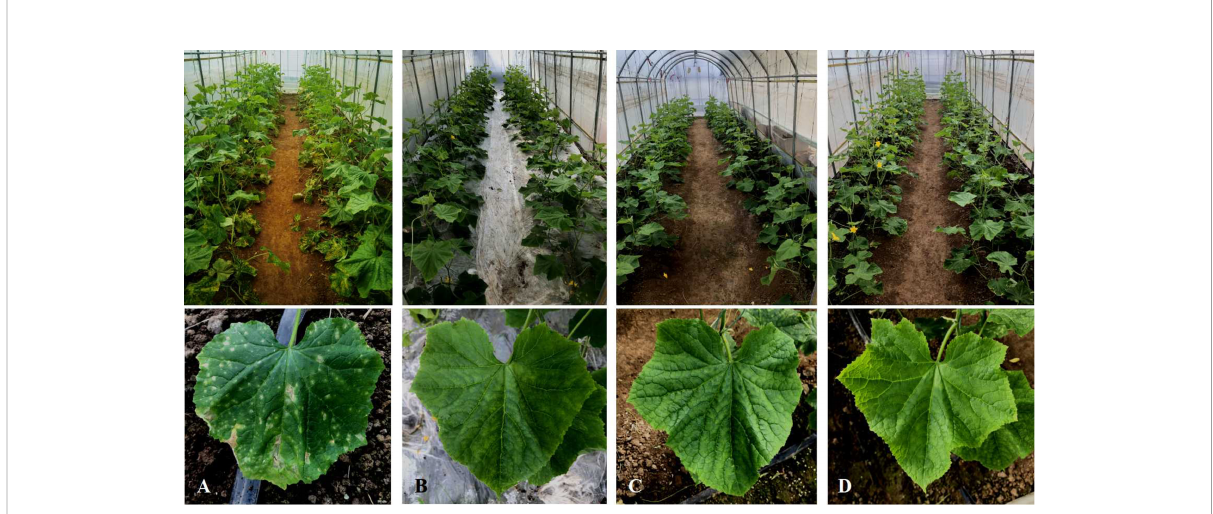
FIGURE 3 Effects of different soil treatments on leaf spot of cucumber seedlings. (A) Plant debris was mixed with sterile soil (CC). (B) Plant debris was mixed into the soil and covered with polyethylene fi lm (CC-PE). (C) Plant debris was mixed into the soil, and CaCN 2 (CC-CaCN 2 ) was added. (D) Natural soil without any treatment (CK).